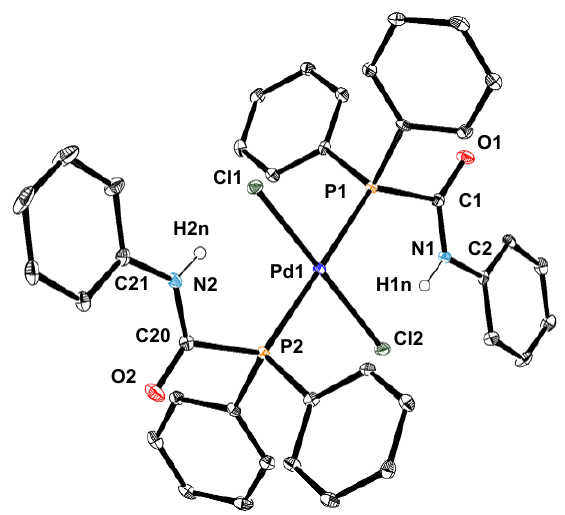
Figure 3. ORTEP drawing of trans - 3 with thermal ellipsoids at 30% probability. Hydrogen atoms (except for NH protons) are omitted for simplicity. Selected bond lengths (Å) and angles ( ◦ ):